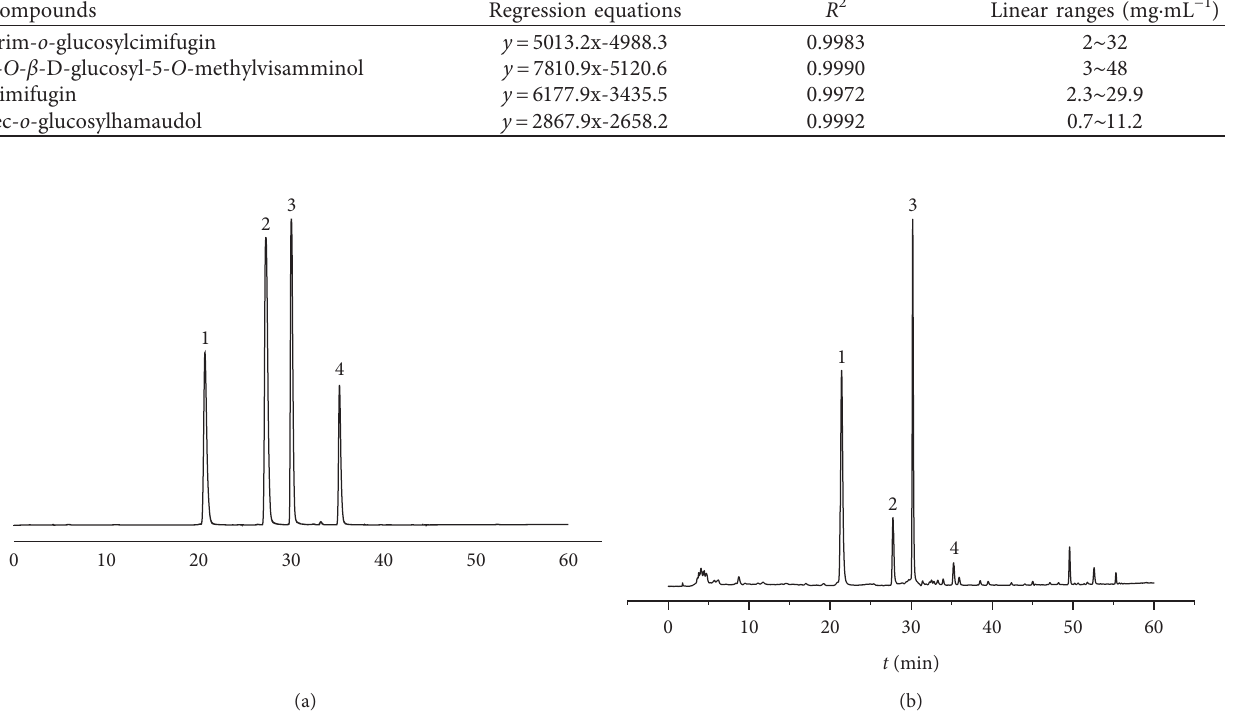
Figure 1: HPLC chromatogram of S. divaricata reference substance solution (a) and HPLC chromatogram of test substance (b). 1: prim-o- glucosylcimifugin; 2: 4-O- β -D-glucosyl-5-O-methylvisamminol; 3: cimifugin; 4: Table 3: Determination of water content and chromone components in 33 batches of S. divaricata .